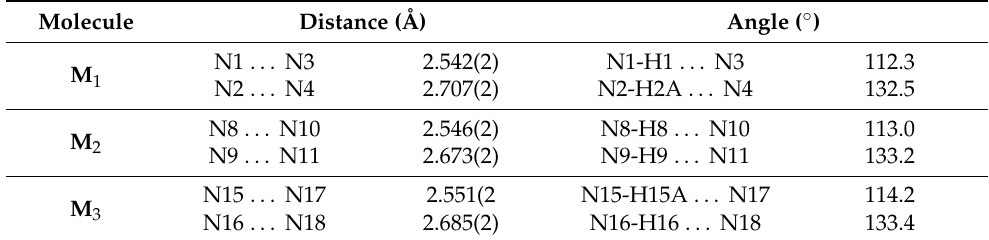
Table 1. Intramolecular hydrogen bond geometry of 3